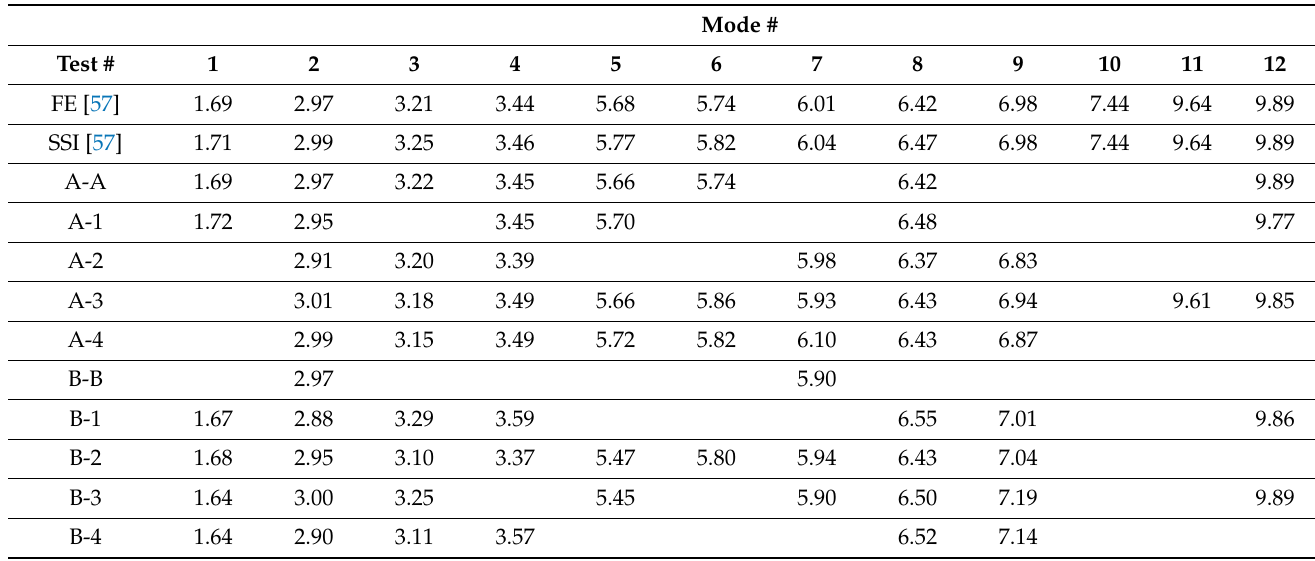
Table 4. Modal frequencies (Hz) of the Eeklo Pedestrian Bridge using TVF-EMD based on its mid- span sensor.